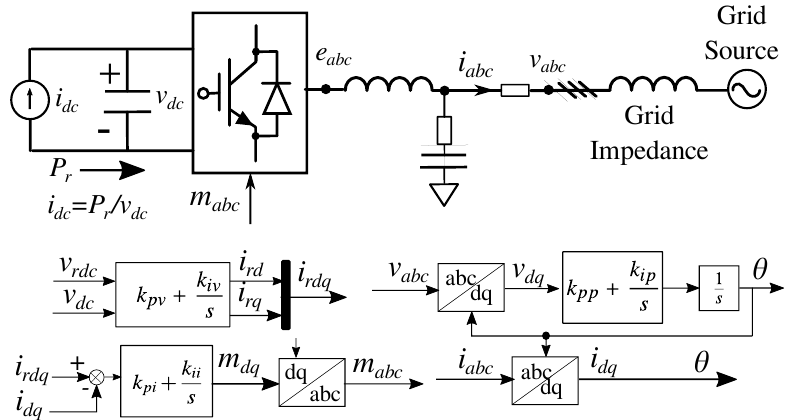
Figure 4. Control diagram of a grid-side converter (GSC) in a type-IV WT.